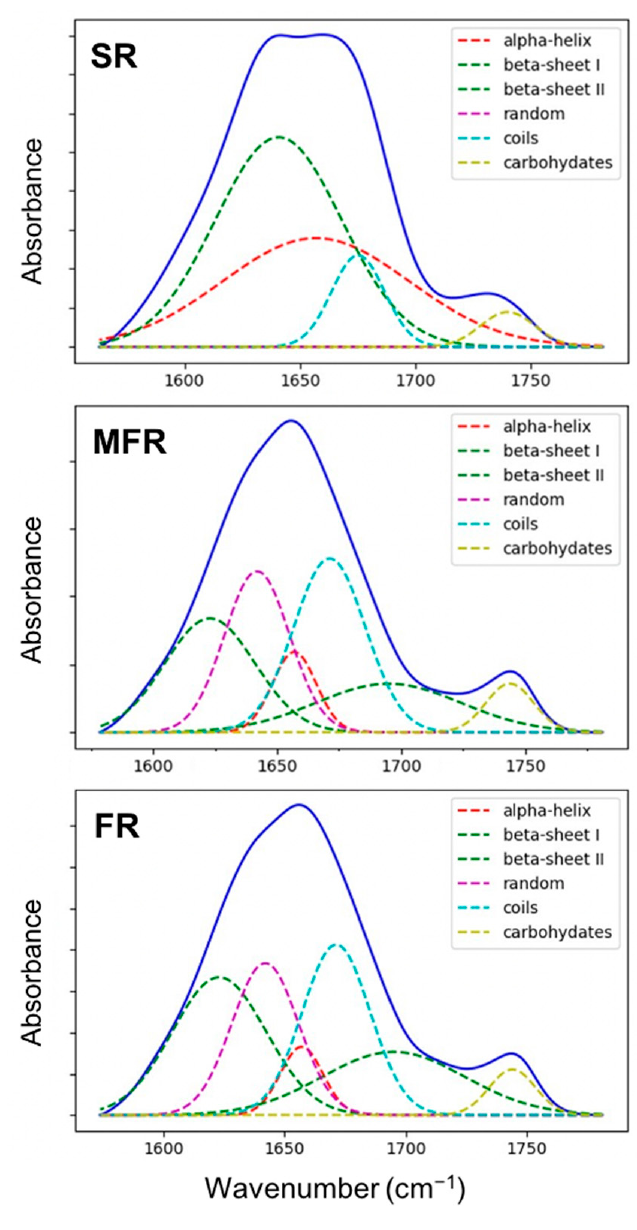
Figure 6. Curve fitting of the region (1580–1780 cm − 1 ) for the root samples derived from each treat- ment (SR, the non-treated seed; MFR, the seeds surrounded by S. mycoparasitica against F. graminearum ; FR, the seed infected by F. graminearum ). Each spectrum is the average of 6 spectra.